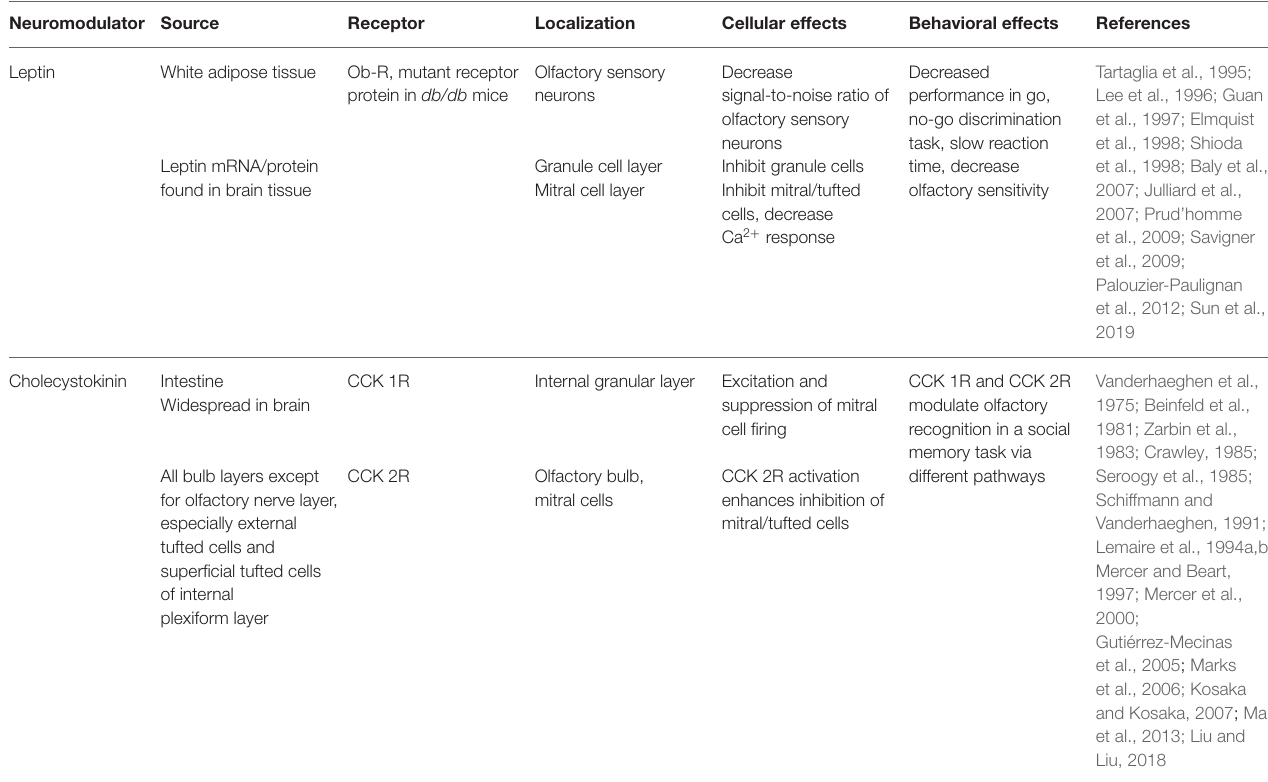
TABLE 1 | Overview of gut peptides and hormones that modulate